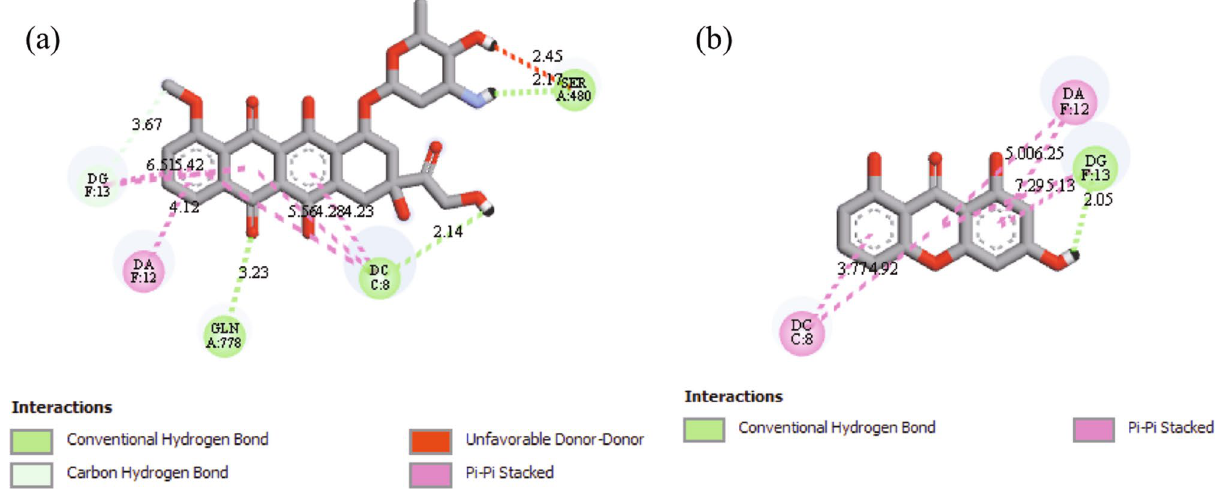
Figure 3. Visualization of the intermolecular interactions of ( a ) doxorubicin and ( b ) hydroxyxanthone 3a with the active sites of topoisomerase